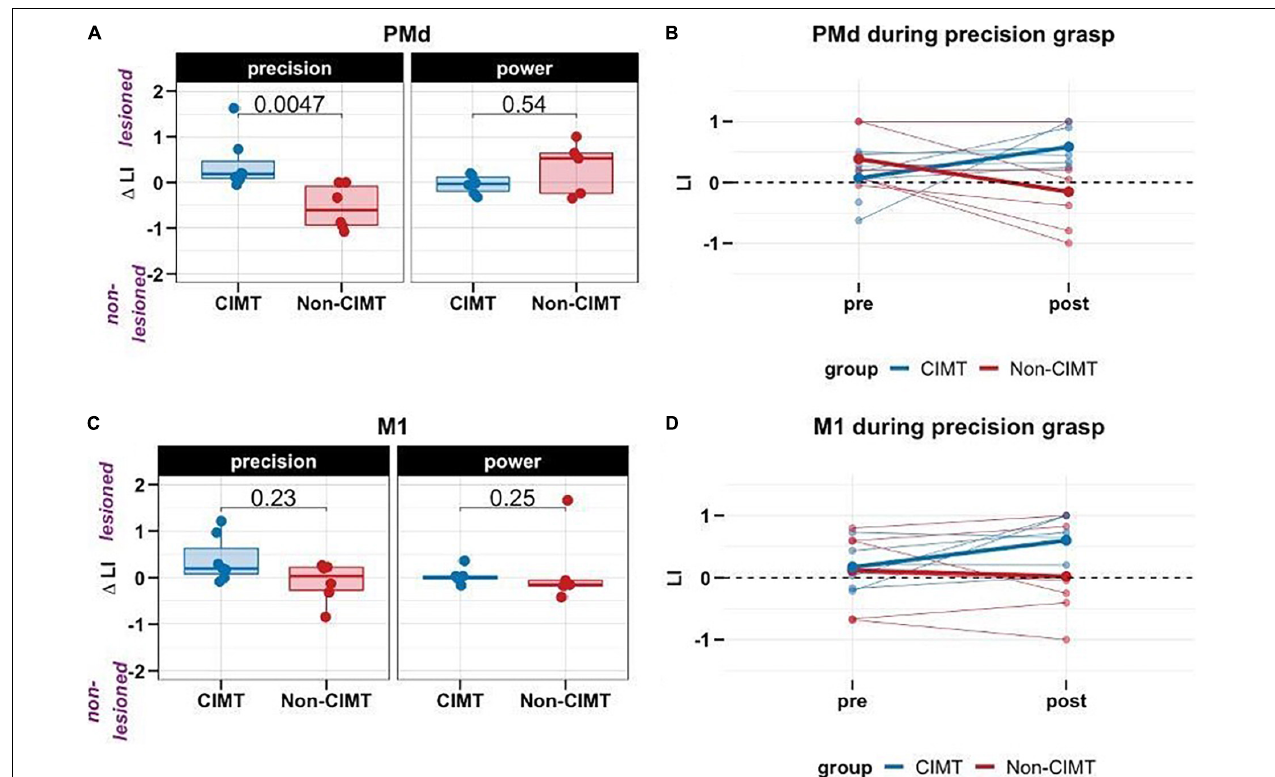
FIGURE 2 | Change in laterality index (LI) across groups and tasks (positive values in (cid:49) LI indicate greater activation of the ROI on the lesioned relative to non-lesioned hemisphere). (A) For the precision task, compared to the non-CIMT group ( n = 6), the constraint-induced movement therapy (CIMT) group ( n = 7) showed increased activation of the dorsal premotor cortex (PMd) in the lesioned hemisphere. However, this effect was not observed for the power task (CIMT group, n = 6, non-CIMT group, n = 5). (B) Individual changes in LI from pre-post in PMd; thicker lines are group means (C) In the primary motor cortex (MI), no changes in LI were observed from pre to post for either group. (D) Individual changes in LI from pre-post in MI; thicker lines are group means. TABLE 2 | Estimates from multiple linear regression. PMd (cid:49) LI MI (cid:49)